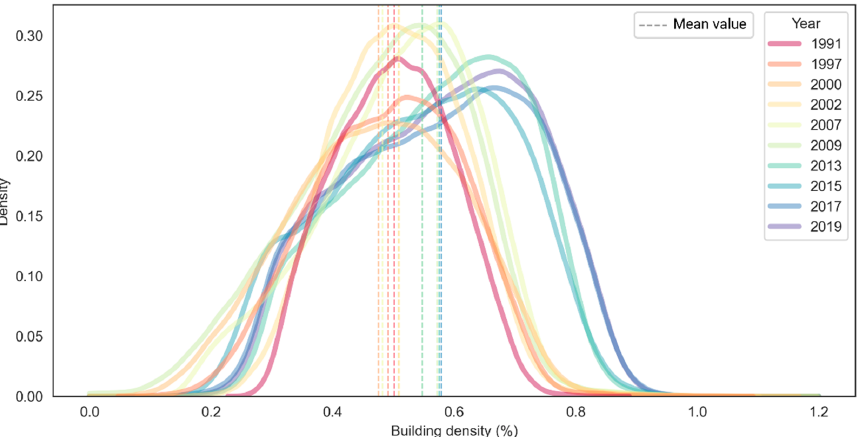
Figure 11. Multi-temporal data distribution of building density map, plotted using kernel density estimation (kde).